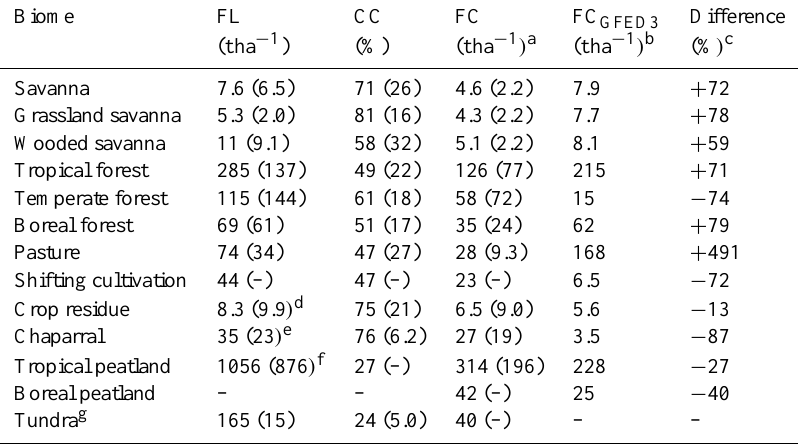
Table 3. Biome-averaged values for fuel load (FL), combustion completeness (CC), and fuel consumption (FC) field measurements. Col- umn 5 shows the FC per unit burned area as used in GFED3 (FC GFED3 ) and in column 6 the difference (%) in FC GFED3 compared to the average FC of field measurements is given. Standard deviation (SD) is shown in